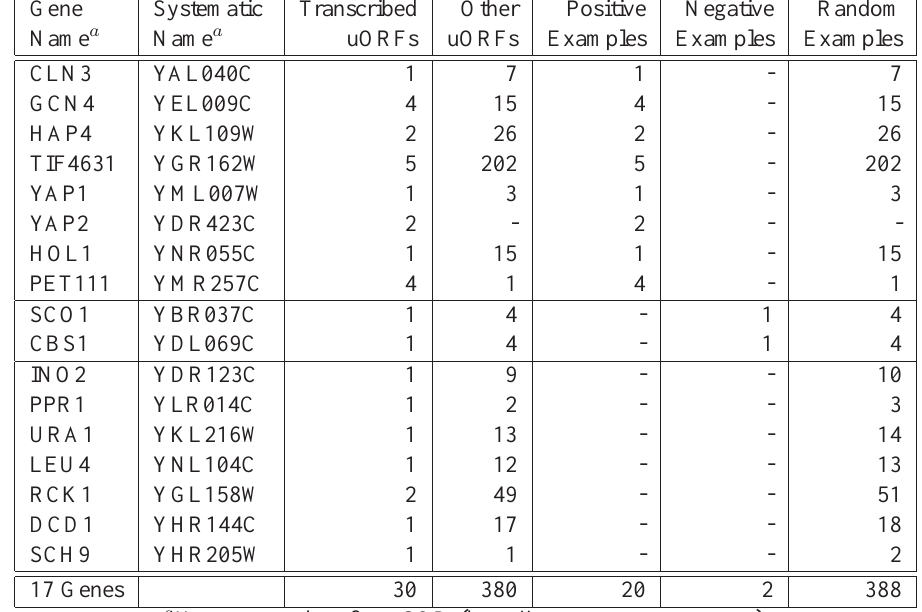
Table 2: Detailed uORF composition from 17 studied genes within the prediction made by ORF Finder [21] Gene Systematic Transcribed Other Positive Negative Random Name a Name a uORFs uORFs Examples Examples Examples CLN3 YAL040C 1 7 1 - 7 GCN4 YEL009C 4 15 4 - 15 HAP4 YKL109W 2 26 2 - 26 TIF4631 YGR162W 5 202 5 - 202 YAP1 YML007W 1 3 1 - 3 YAP2 YDR423C 2 - 2 - - 15 YBR037C 1 4 - 4 CBS1 YDL069C 1 4 - 4 INO2 YDR123C 1 9 - - 10 PPR1 YLR014C 1 2 - - 3 URA1 YKL216W 1 13 - - 14 LEU4 YNL104C 1 12 - - 13 RCK1 YGL158W 2 49 - - 51 DCD1 YHR144C 1 17 - - 18 SCH9 YHR205W 1 1 - - 2 17 Genes 30 380